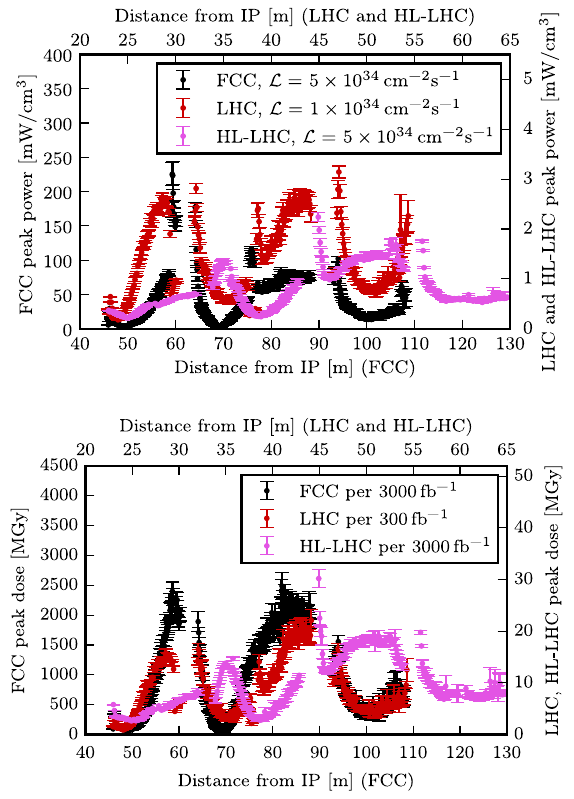
FIG. 4. Peak power densities (top) and peak doses (bottom) for the first lattice compared with LHC and HL-LHC for horizontal crossing. The horizontal axes were chosen to overlap similar magnets in the LHC and FCC lattices. The crossing angles were 285 μ rad for LHC, 590 μ rad for HL-LHC and 86 μ rad for FCC.